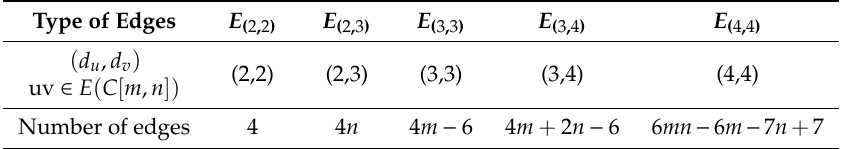
Table 1. Edge partition of coordination nanosheet C [ m , n ] .